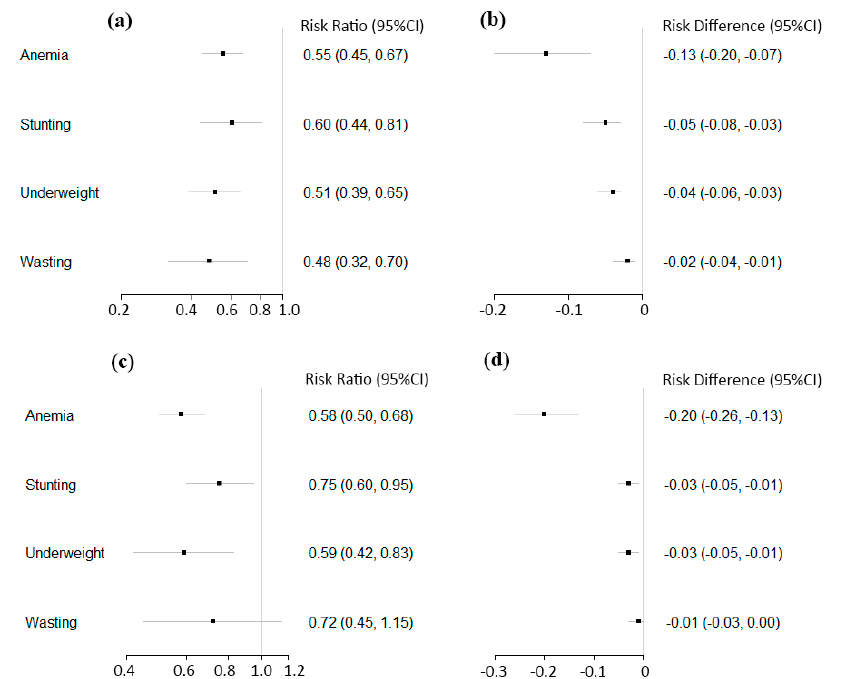
Figure 3. The effect of YYB on the prevalence of anemia and child anthropometric outcomes in China among post-only studies with concurrent-control using risk ratios ( a ) and risk differences ( b ), and among pre-post studies, using risk ratios ( c ) and risk differences ( d ).